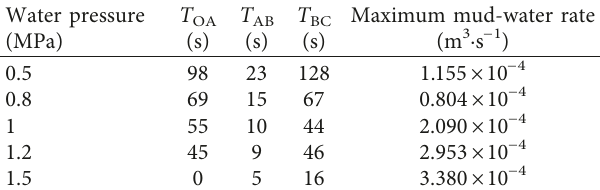
Table 2: Experimental data of mud-water mixture